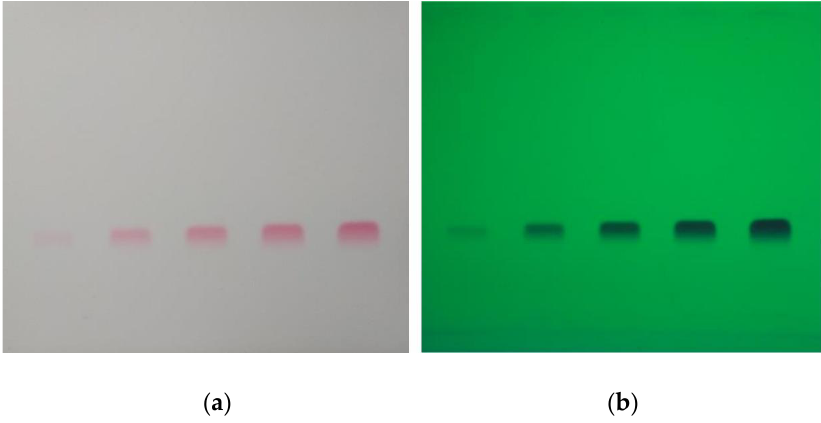
Figure 2. An example of chromatograms (image) for vitamin B12 with different concentrations (in the linearity range) registered in ( a ) daylight and ( b ) under a UV lamp (254 nm). Additionally, different developing lengths (95 and 145 mm) of tested stationary phase were checked. A similar distribution and recorded R F values were obtained, and finally the plates were developed to 95 mm.